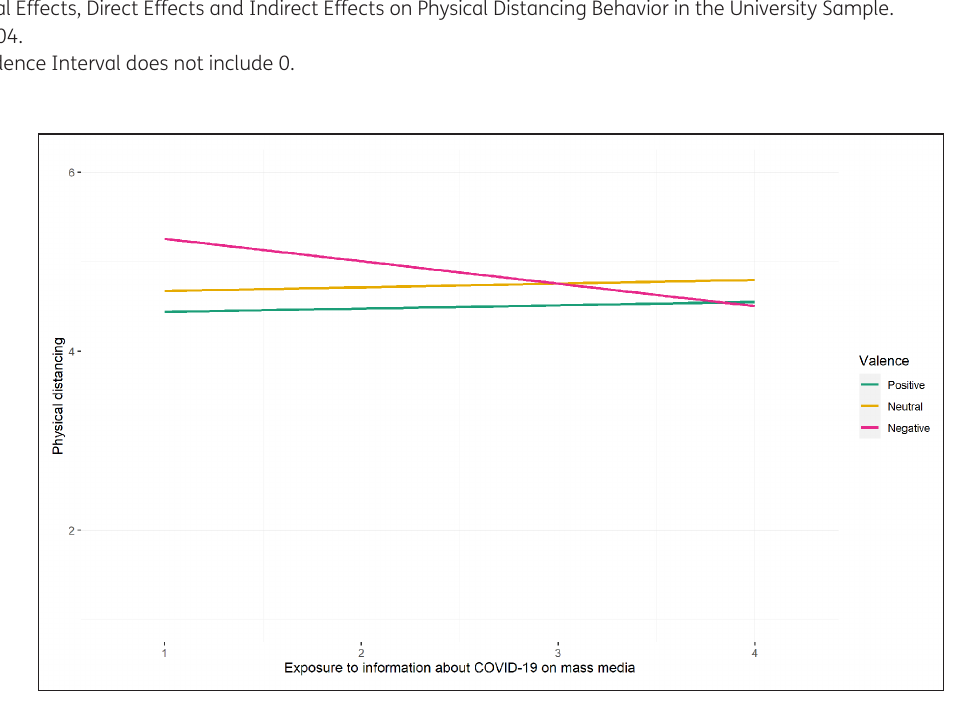
Table 9 Total Effects, Direct Effects and Indirect Effects on Physical Distancing Behavior in the University Sample. Note : N = 404.